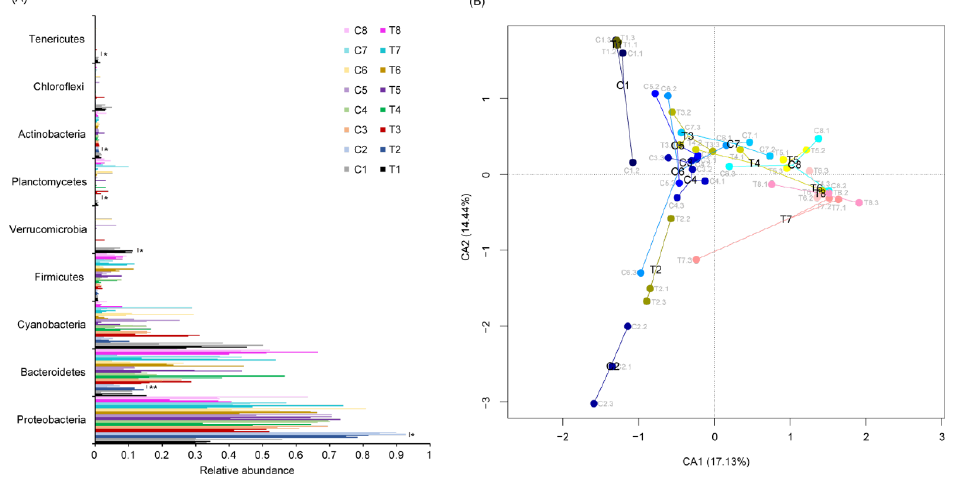
Figure 2. Varying dominant phyla between treated and control water samples on different days after adding Pseudomonas furukawaii ZS1 ( A ) and PCA profile based on OTU compositions of each water sample ( B ). Different colorful circles in the panel ( B ) indicate different groups collected different days after adding P. furukawaii ZS1. Mid-night blue, navy blue, slate blue, royal blue, blue, dodger bule, deep sky blue, and cyan indicate controls collected at first, second, third, fourth, fifth, sixth, seventh, and eighth day after adding P. furukawaii ZS1, respectively; and saddle brown, dark olive green, dark goldenrod, gold, yellow, bisque, coral, and dark salmon indicate treatments collected at first, second, third, fourth, fifth, sixth, seventh, and eighth day after adding P. furukawaii ZS1, respectively. *, p < 0.05; **, p <